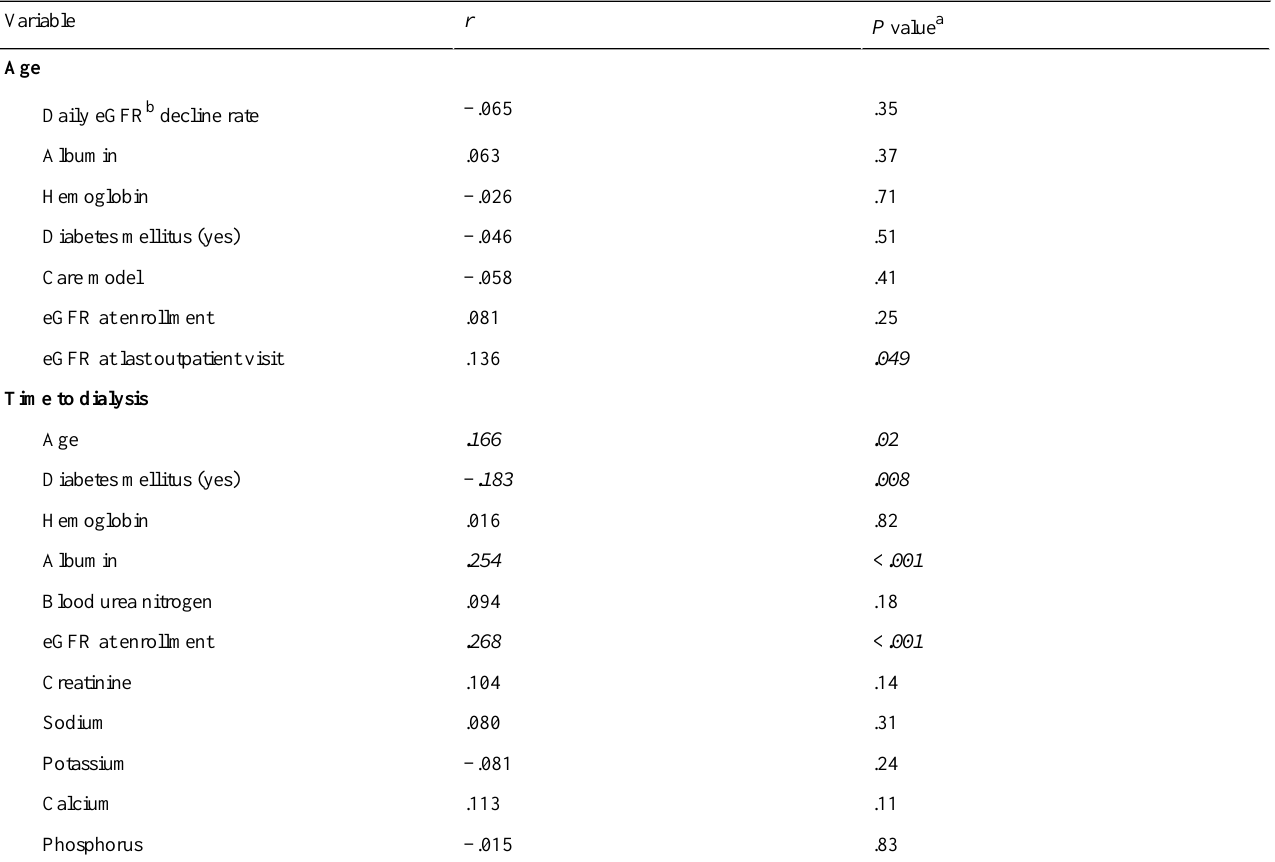
Table 2. Pearson correlations ( r ) between age and other risk factors, and time to dialysis and other risk factors, among enrolled patients with stage 5 chronic kidney